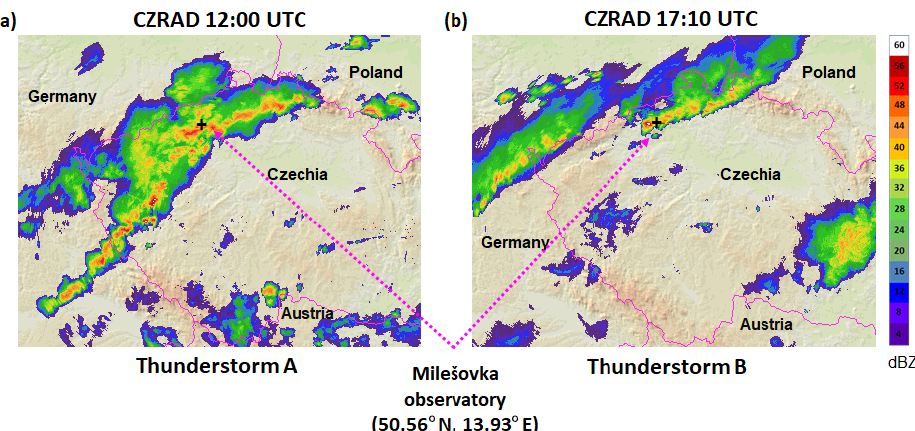
Figure 1. Maps of radar reflectivity for the most intense parts of storm A (a) and storm B (b) . Black crosses show location of the Milešovka observatory (source: http://www.chmi.cz on 23 April